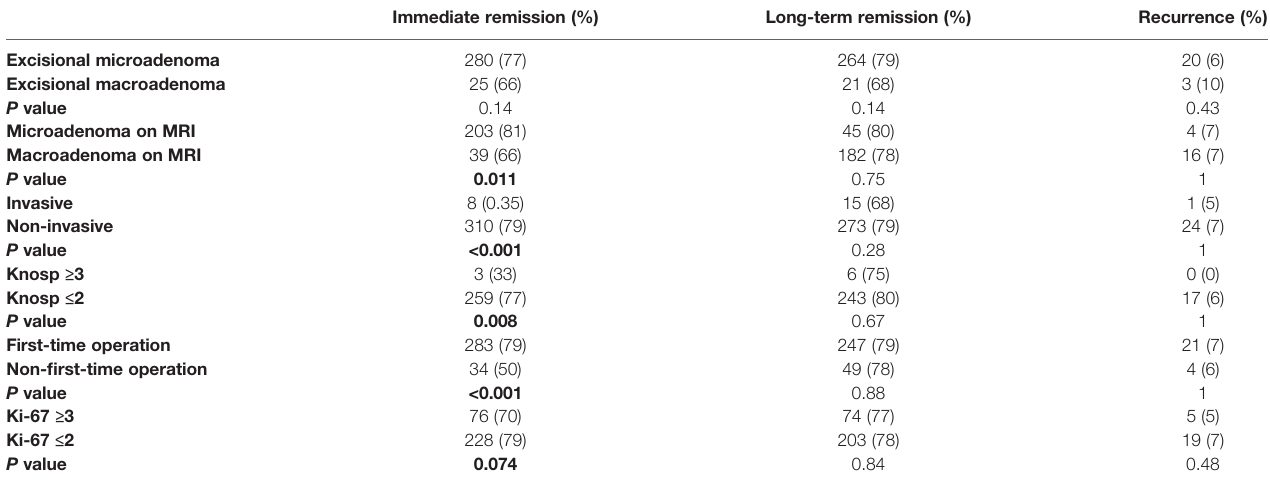
TABLE 5 | Prognosis of patients treated with TSS.